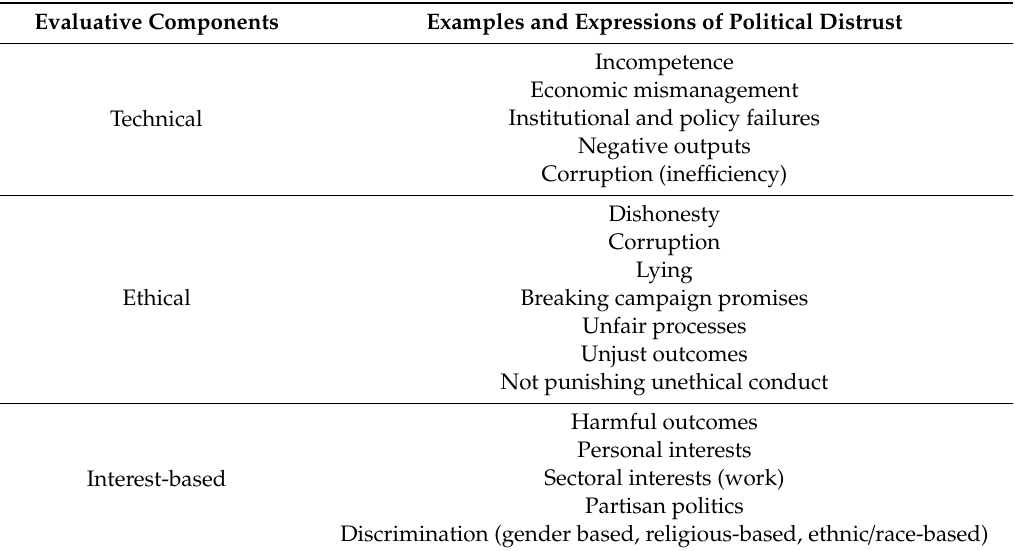
Table 3. Evaluative components of political